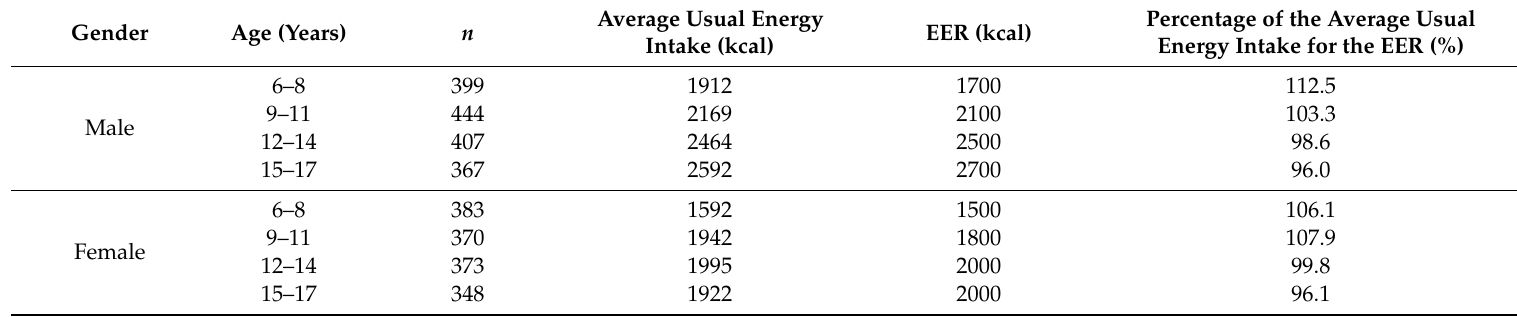
Table 2. The percentage of the average usual energy intake to the estimated energy requirement (EER) among Korean school-aged children and